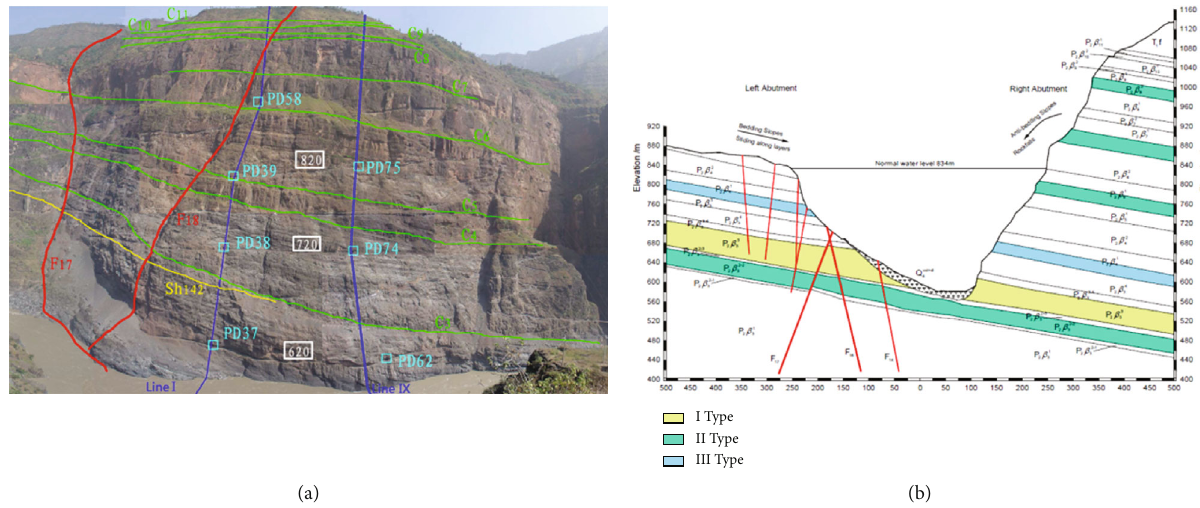
Figure 3: Pro fi le distribution of columnar basalt at Baihetan dam site: (a) left bank of dam site and (b) pro fi le information of Line